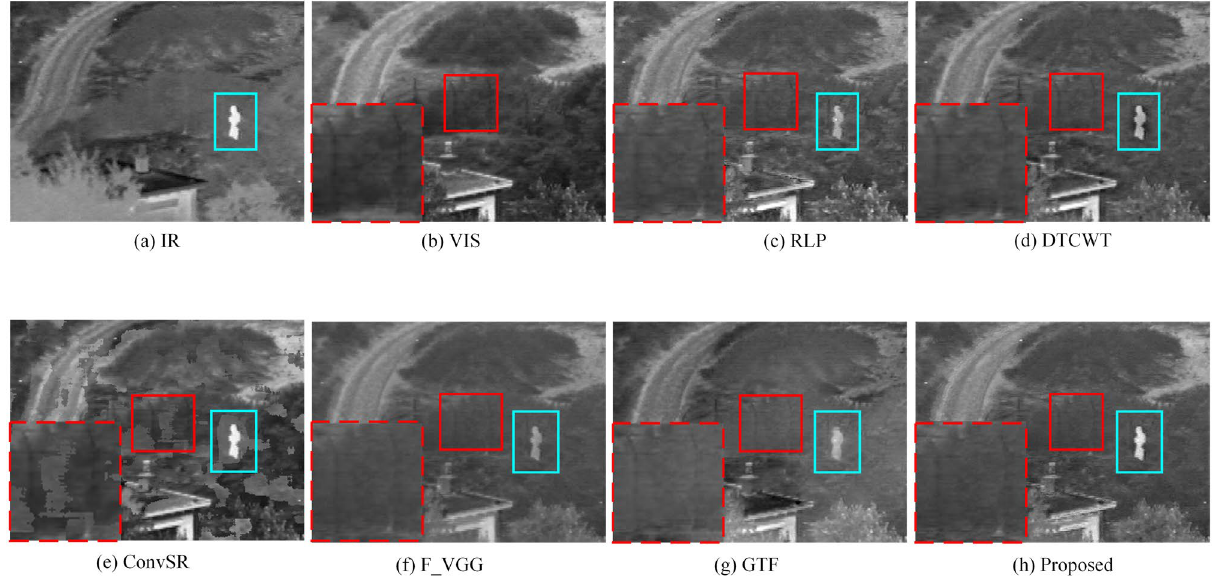
Figure 8. “Sentry” source image pair and their fused images obtained with different fusion methods.